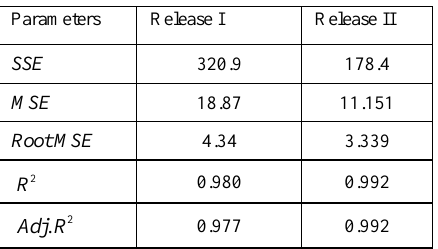
Table 2. Comparison criteria for Release I &